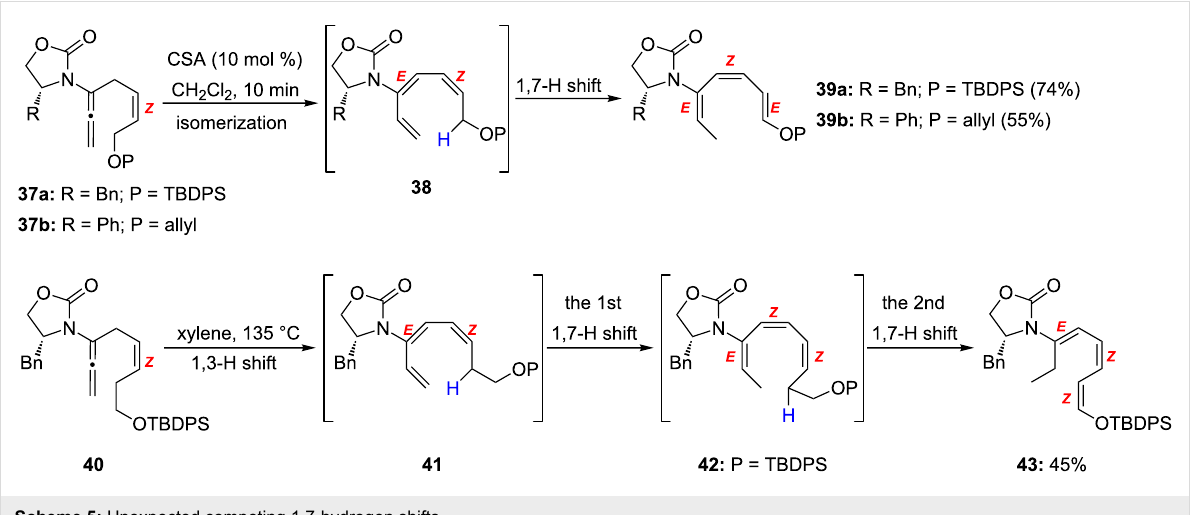
Scheme 5: Unexpected competing 1,7-hydrogen shifts.